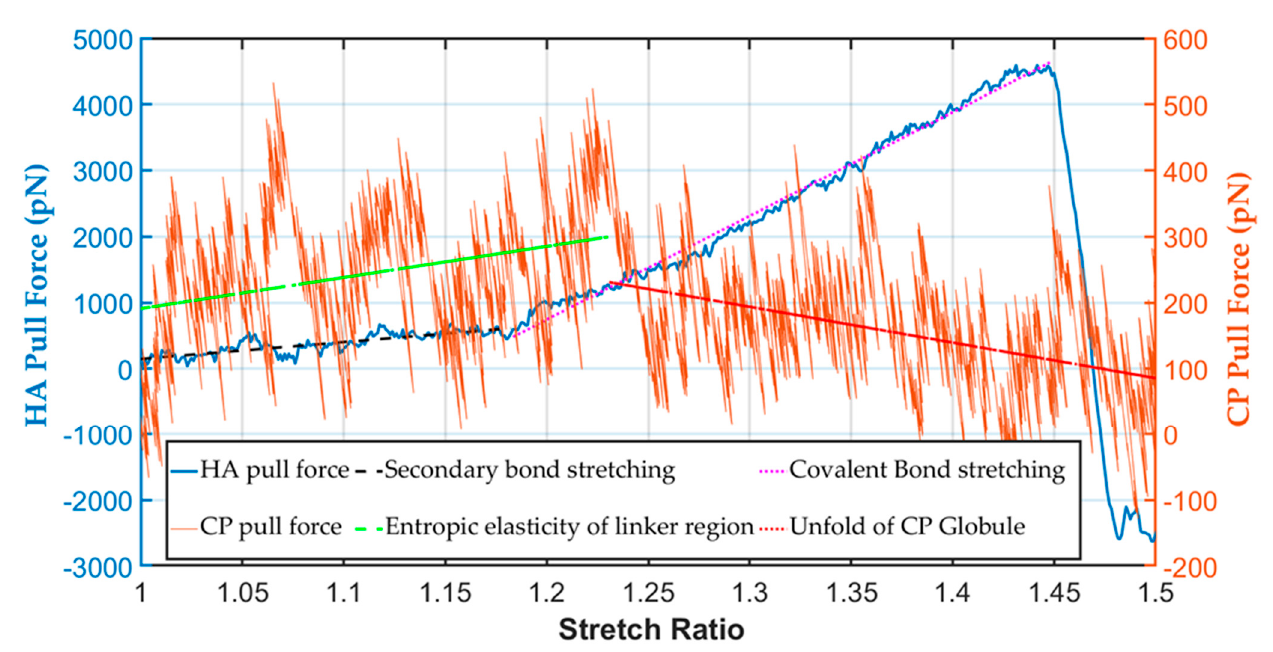
Figure 5. Mechanical strength of the PNN CP and HA components at 1 kms (cid:2879)(cid:2869) pulling speed.